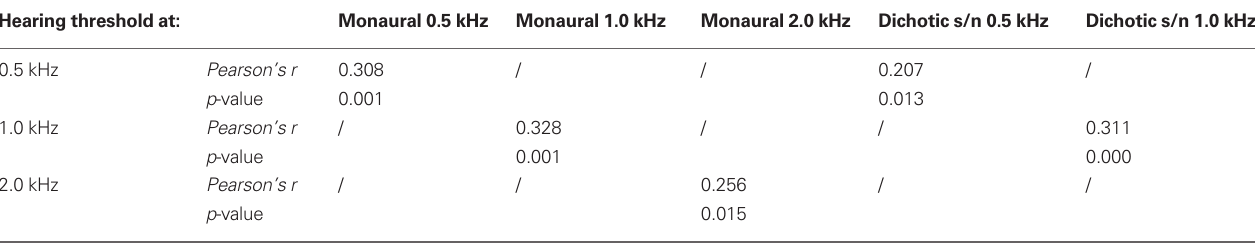
Table 2 | Pearson’s correlation coefficient Pearson’s r of test mode (monaural and dichotic s/n) and hearing threshold (0.5; 1.0; and 2.0 kHz) of duration